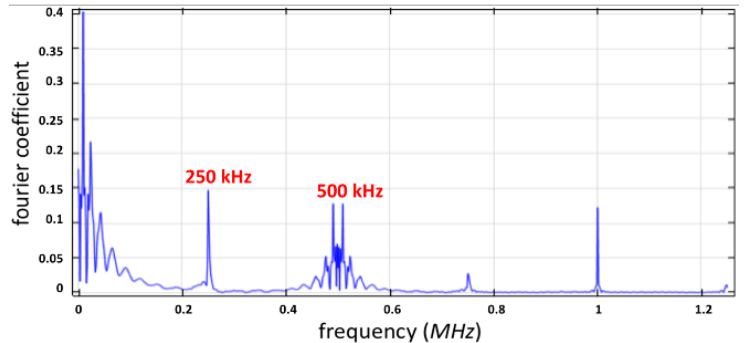
Figure 6. The frequency spectrum at the position ( L /2, h ) for h cr = 0.36 µ m.